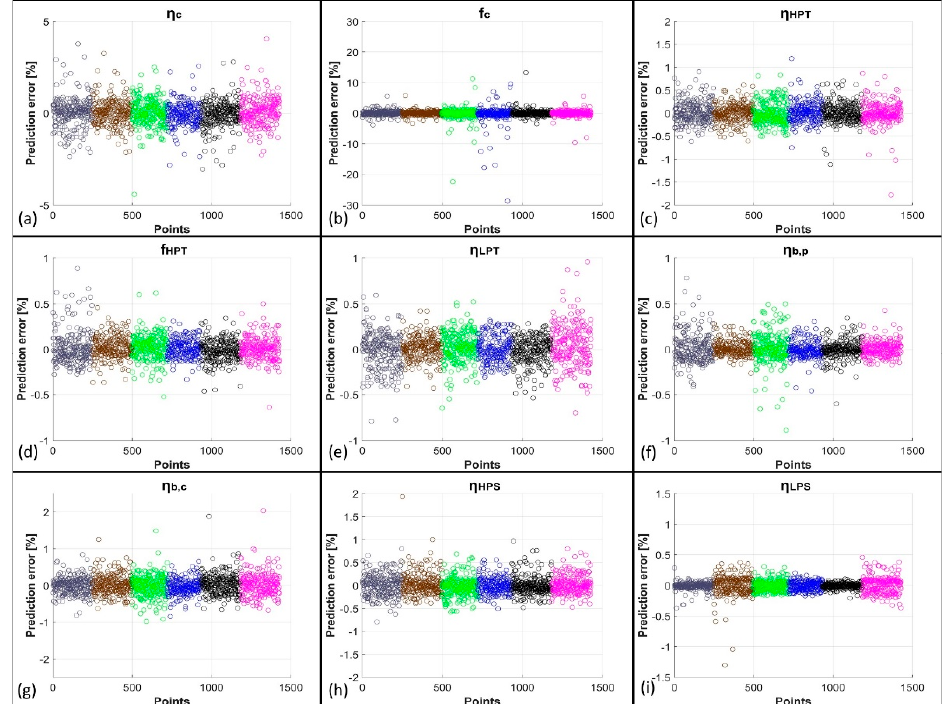
Figure 8. ( a – i ) Percentage errors between FFNN predictions and targets about the PPs related to the multi-component degradation condition. Grey: START-A; brown: START-B; green: MAXPOW-A; blue: MAXPOW-B; black: MAXDUR-A; magenta: MAXDUR-B.